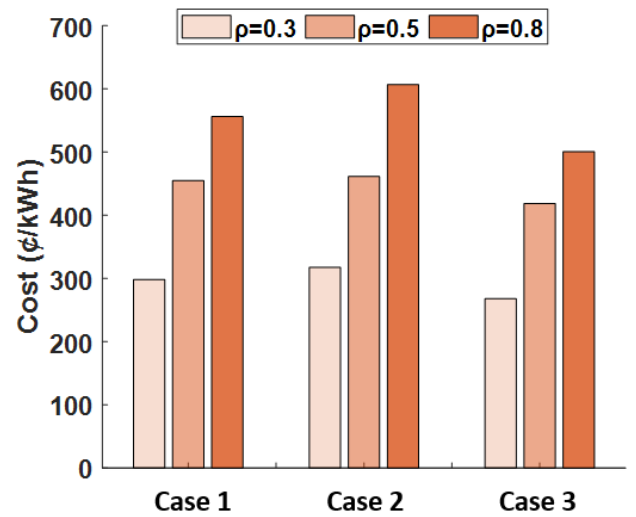
Figure 8. The impact of the balance parameter on electricity consumption.